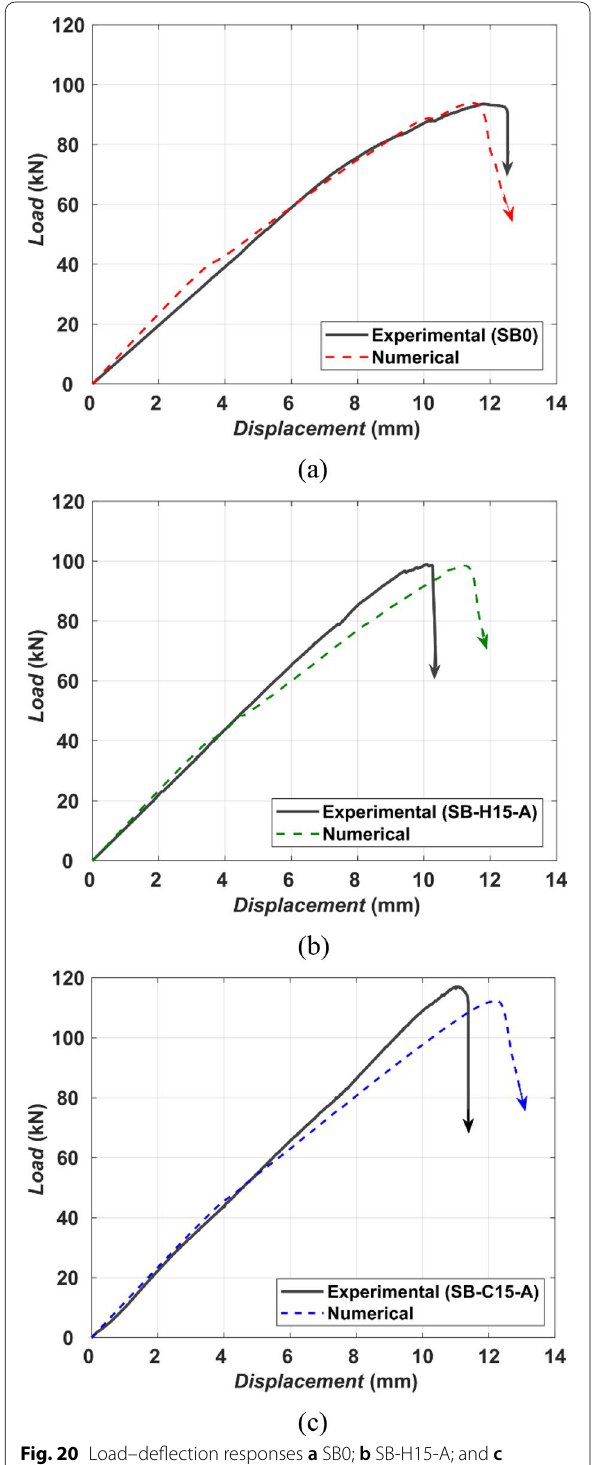
Fig. 20 Load–deflection responses a SB0; b SB‑H15‑A; and c